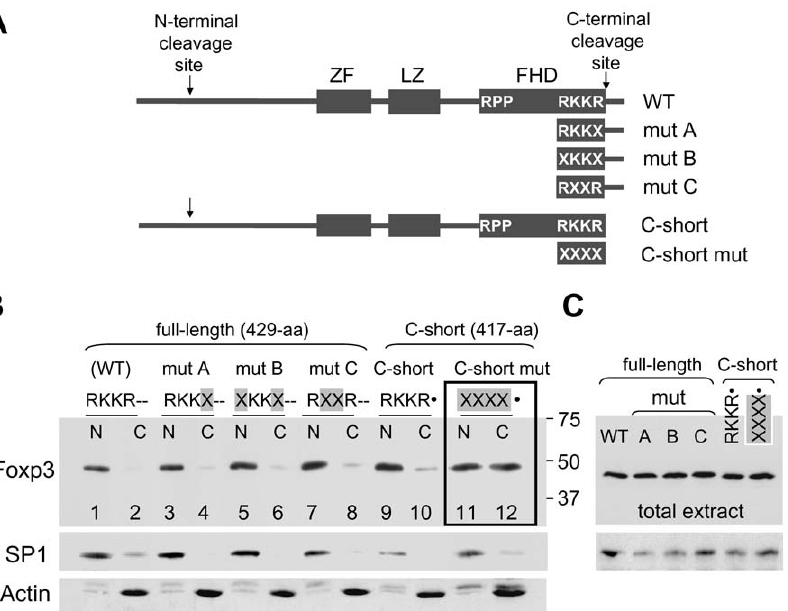
Figure 1. Comparison of the nuclear translocation abilities of WT Foxp3 and Foxp3 mutants. A. Schematic diagram showing the approximate locations of the zinc-finger (ZF), leucine-zipper (LZ) and the forkhead domain (FHD) in the full-length WT mouse Foxp3. Vertical arrows indicate sites of proteolytic cleavage. The amino acid sequences RPP and RKKR shown in the schematic diagrams represent the first and the last residues of the FHD. Mutant residues in mut A, mut B, mut C, and C-short mutant Foxp3 are indicated with an X. The lower diagram shows the structure of C-short Foxp3 lacking the terminal 12-aa tail. This engineered Foxp3 mimics the natural C-cleaved form of the protein, a result of proteolytic processing at 414 RKKR Q S 418 . B. Western blot showing nuclear and cytoplasmic distribution of WT Foxp3 (RKKR--), mut A (RKKX--), mut B (XKKX--), mut C (RXXR--), C-short Foxp3 (RKKR N ) and C-short Foxp3 mutant (XXXX N ). Lanes 11 and 12 (inside the frame), corresponding to C-short mutant (XXXX N ), reveal an impaired rate of nuclear translocation. CD4 + cells were harvested 24 hr after retroviral transduction and subcellular fractions obtained. Mutant residues on all the Western blot figures are shown with X and highlighted in grey. N indicates engineered ends and double dashes (--) indicate the 12-aa tail. Following treatment with the Foxp3 mAbFJK-16s, the membrane was treated with SP1 and Actin antibodies to determine the efficiency of subcellular fractionation. The second species migrating slightly slower then Actin in lanes 1-12 is Foxp3. Foxp3 signal was generated along with the Actin signal due to previous treatment of the membrane with Foxp3 antibody. N, nuclear extract; C, cytoplasmic extract. The N and C designations are used in all the figures. C. Western blot showing equal Foxp3 expression in total extracts obtained from samples shown in B. SP1 signal was used to determine